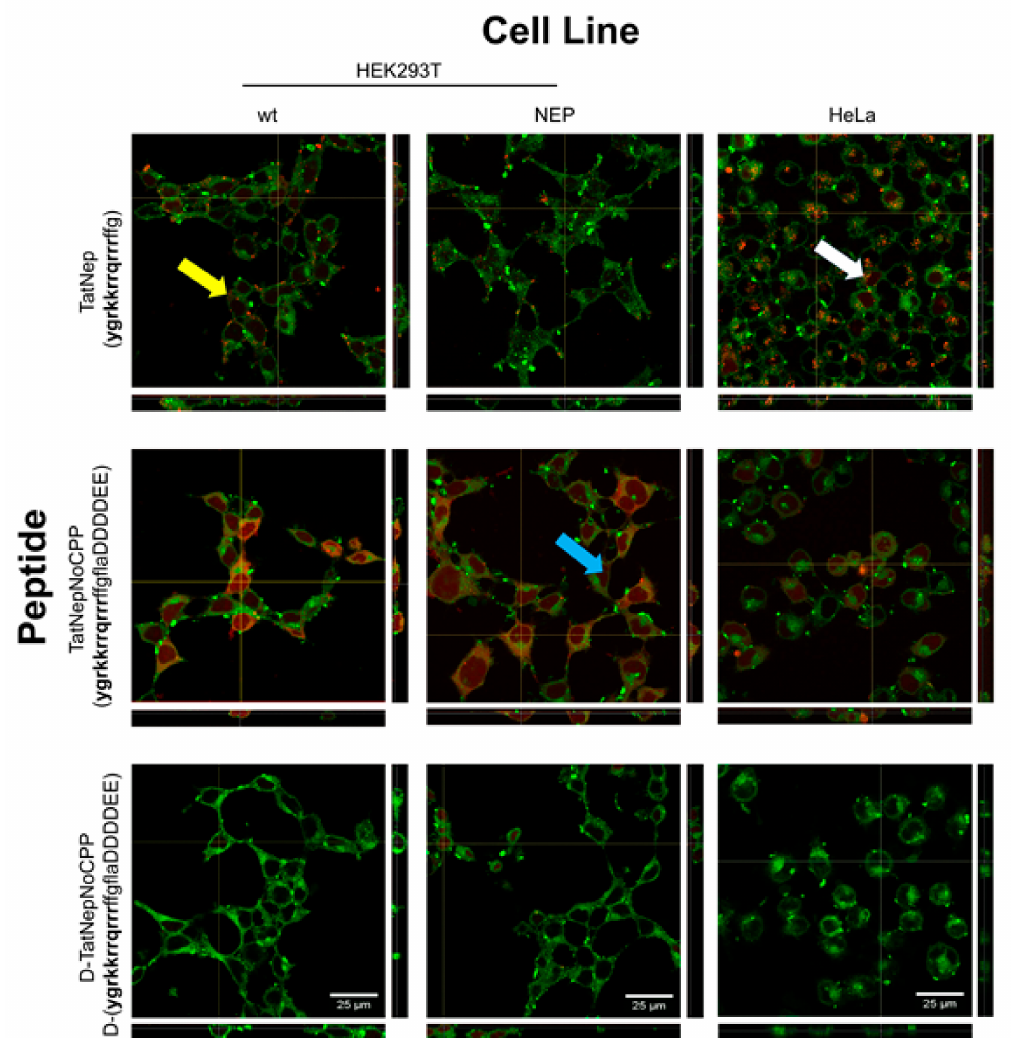
Figure 7. Confocal microscopy of mammalian cells exposed to selective CPPs. Orthogonal projections of cells exposed to fluorescent CPPs (5 µ M) to estimate internalization in HEK293T, HEK293T-NEP and HeLa cell lines are presented. Original stack images (“xy” coordinates) in the middle and “yz” and “xz” projections at the right and bottom, respectively. Yellow (punctuated), blue (diffuse) and white (punctuated and diffuse) arrows indicate examples of the three distinct fluorescent patterns observed. White bars represent 25 µ